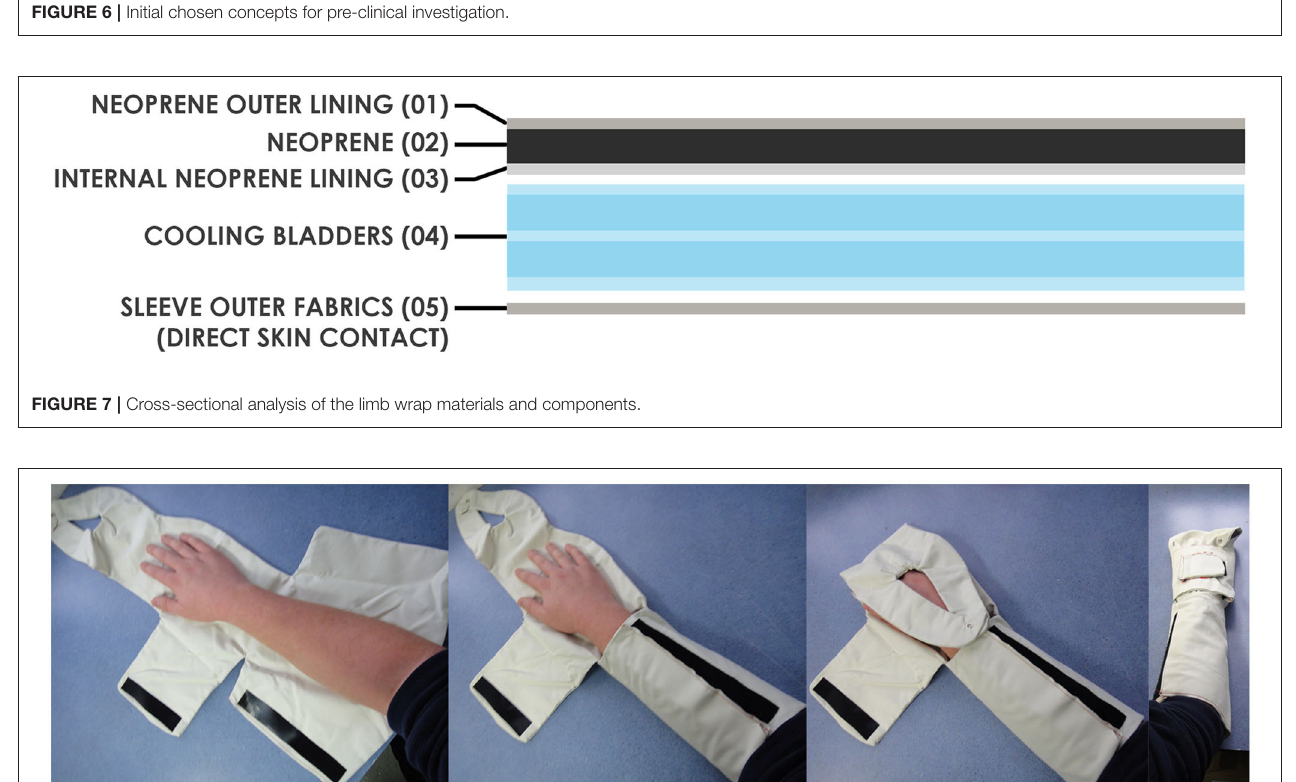
FIGURE 6 | Initial chosen concepts for pre-clinical investigation.